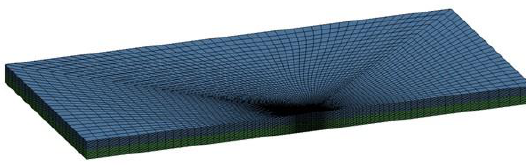
Figure 7. The mesh model with finite elements for the composite structure.